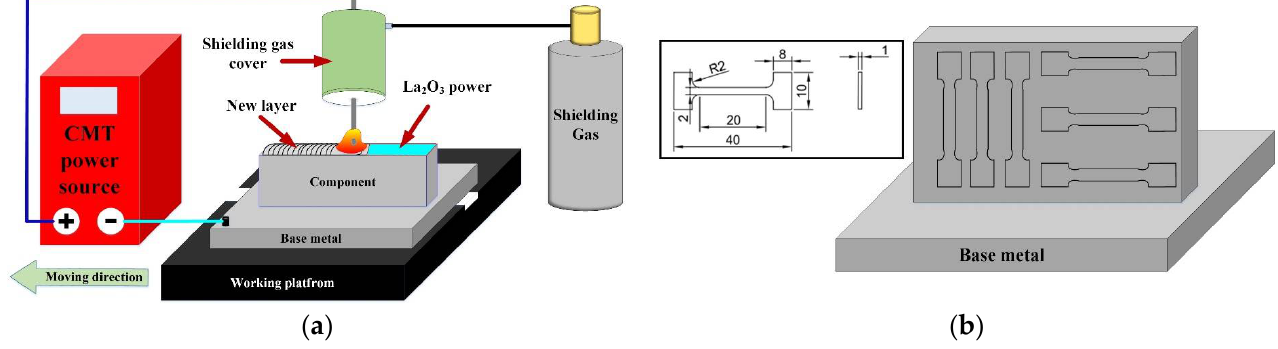
Figure 1. Schematic diagram of CMT additive manufacturing system and tensile specimens. ( a ) CMT additive manufacturing system and ( b ) Tensile specimens.